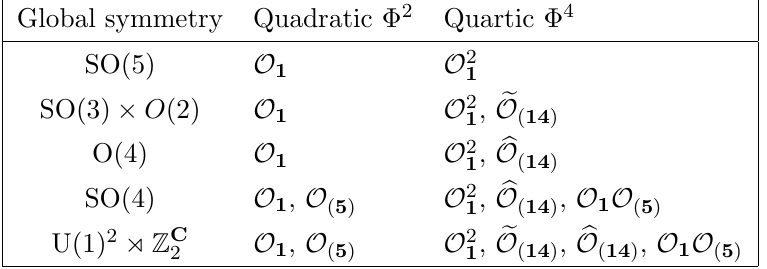
depending on the preserved global 0